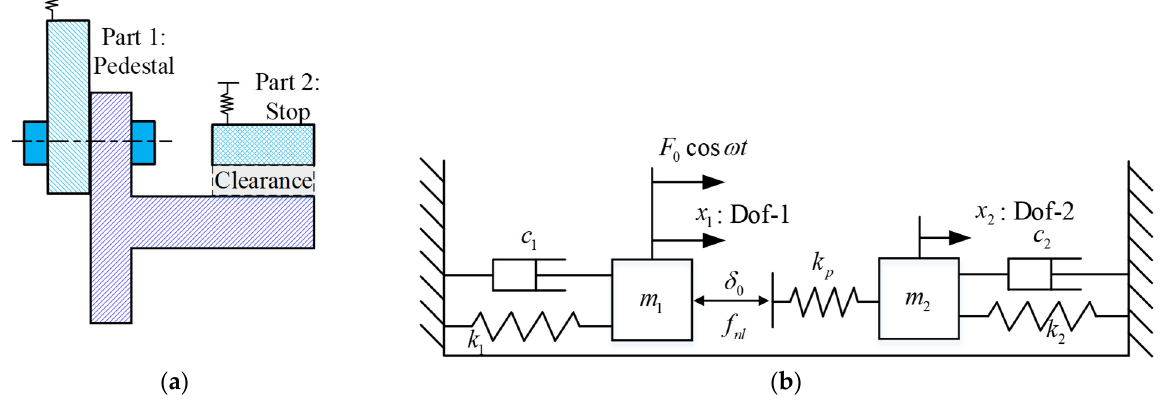
Figure 1. Pedestal with an elastic stop and its dynamic model: ( a ) pedestal with an elastic stop; ( b ) dynamic model.